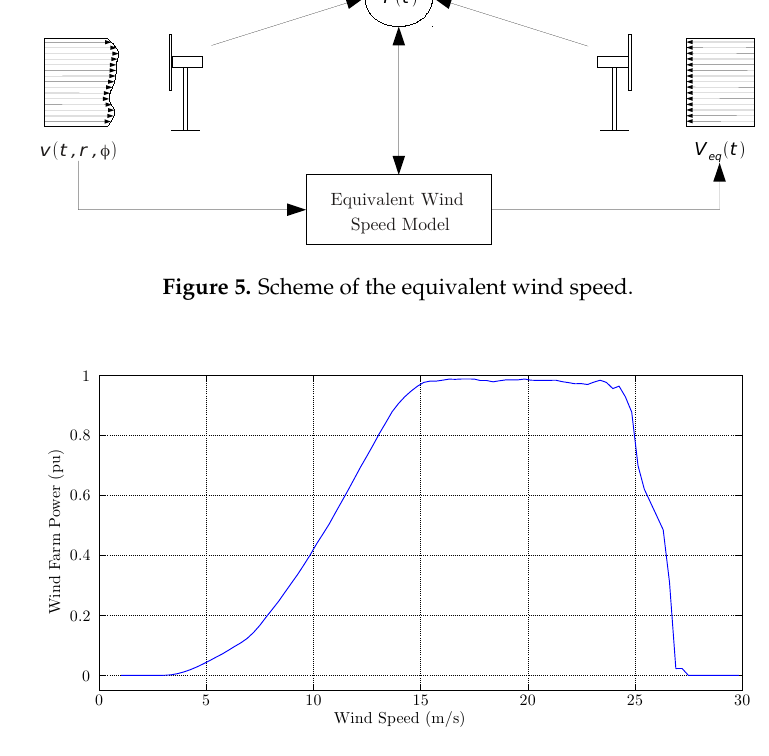
Figure 6. Aggregated wind farm power